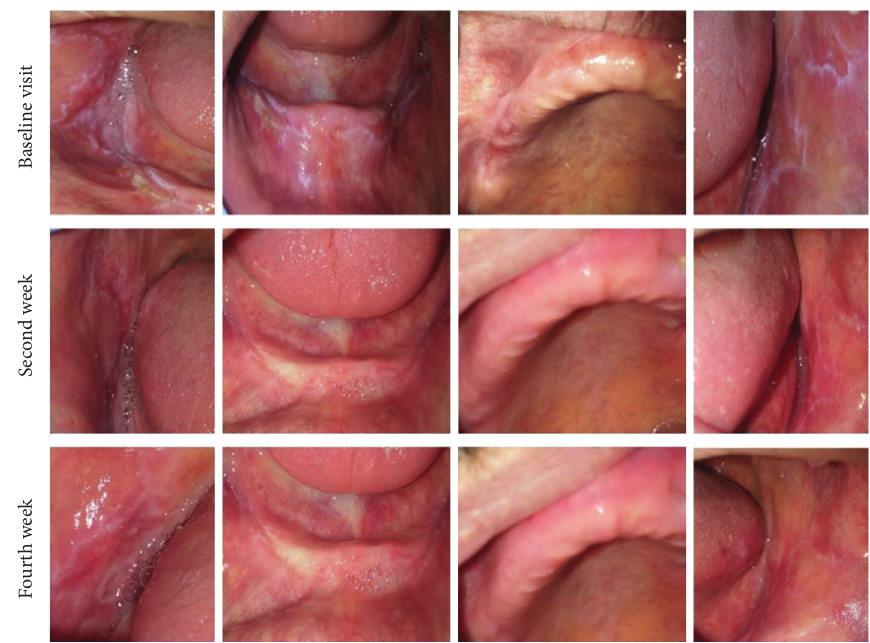
Figure 1: Intraoral photographs of a patient in the nanocurcumin group at baseline and at two and four